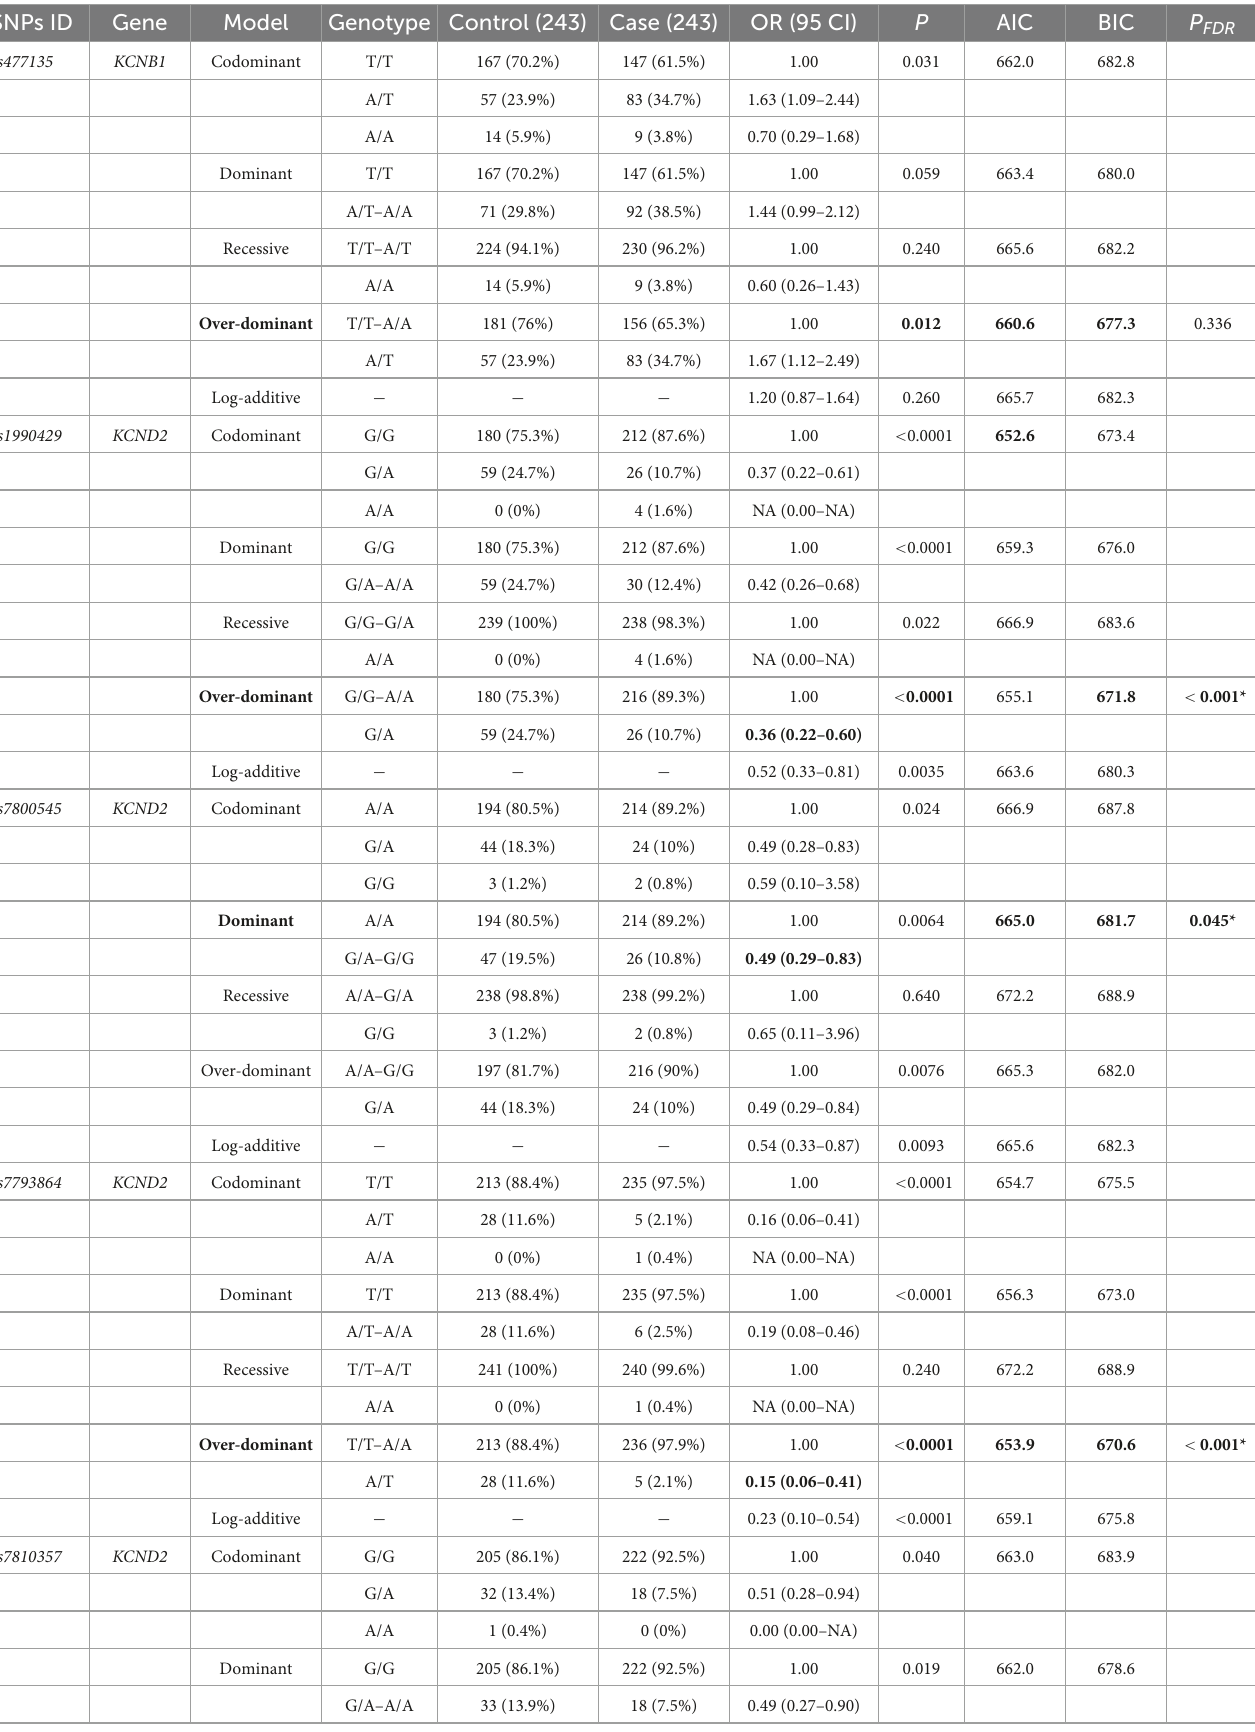
TABLE 5 KCNB1 and KCND2 single nucleotide polymorphisms (SNPs) in different genetic models associated with autism spectrum disorder (ASD) risk. SNPs